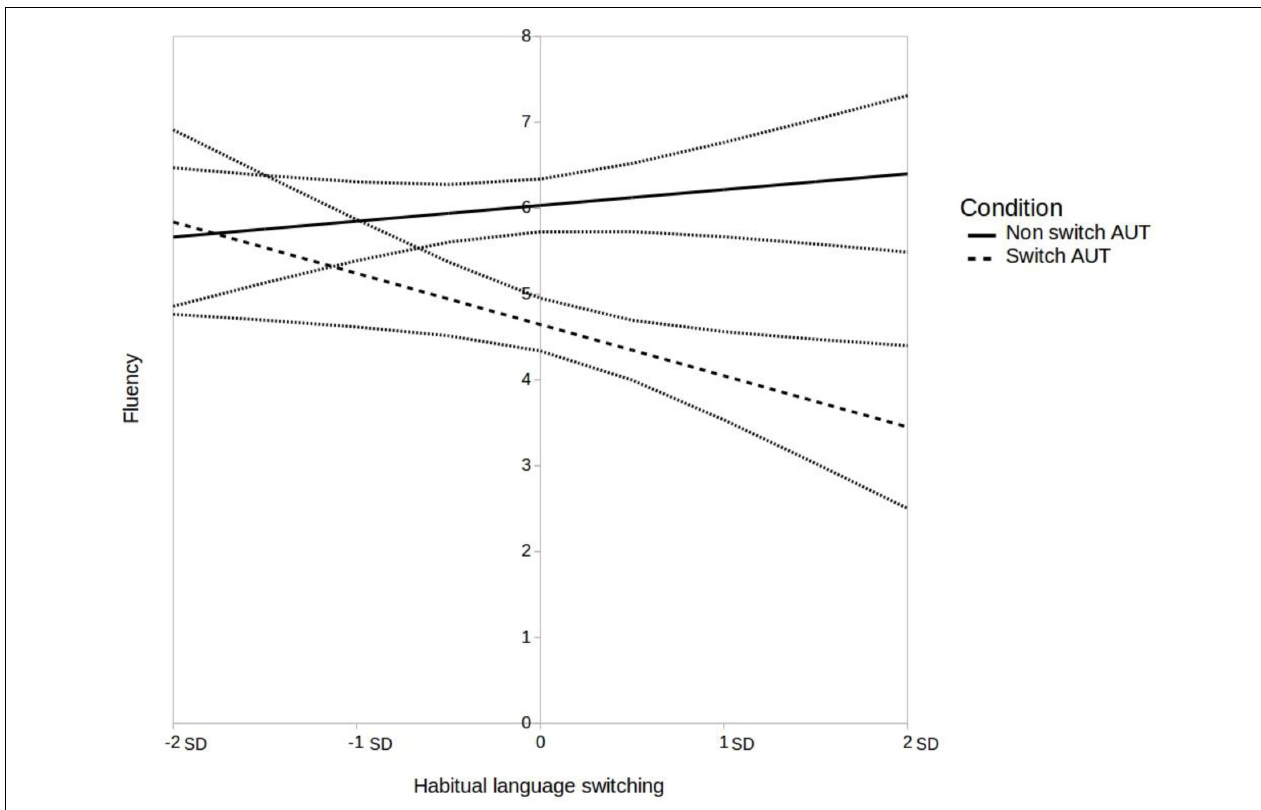
FIGURE 1 | Interaction of language switching condition and habitual language switching on fluency scores. 95% confidence intervals are represented by gray lines.